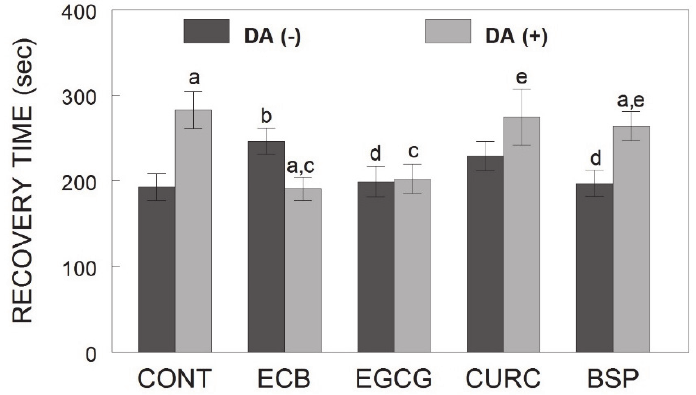
Figure 2. Calcium recovery time in E18 rat hippocampal neurons pre-treated with ECB or its component phytochemicals (EGCG, CURC, BSP) and stimulated for 2 h with DA (0.0 or 0.1 mM). Data are expressed as mean time (seconds) to return to baseline calcium levels after depolarization ± SEM. a = p < 0.05 vs. non-DA-treated cells matched for each treatment; b = p < 0.05 vs. non-DA-treated control cells; c = p < 0.05 vs. DA-treated control cells; d = p < 0.05 vs. non-DA-treated ECB cells; e = p < 0.05 vs. DA-treated ECB cells; Fisher’s LSD post-hoc test. DA = dopamine; CONT = control; ECB = combination compound; EGCG = epigallocatechin gallate; CURC = curcumin; BSP = broccoli sprouts.